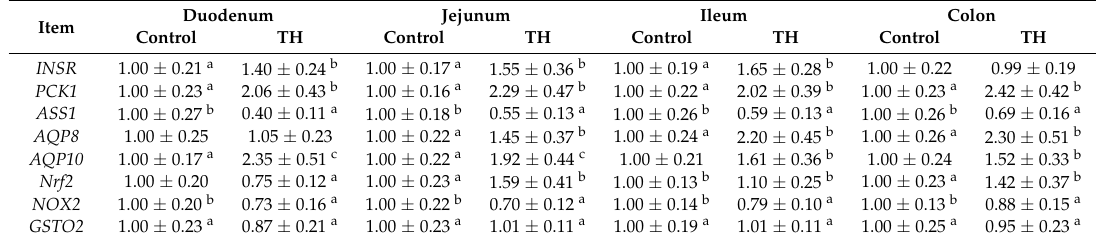
Table 5. Relative expression levels of genes associated with intestinal glycogen metabolism and function in tissues of piglets receiving dietary supplementation with or without trihexanoin (TH).